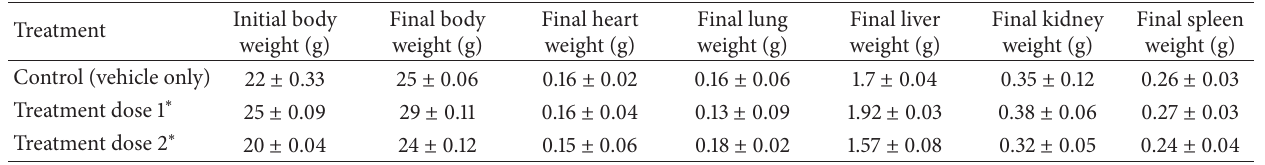
Table 1: Effect of p-PD treatment on body weight with major organ weight in